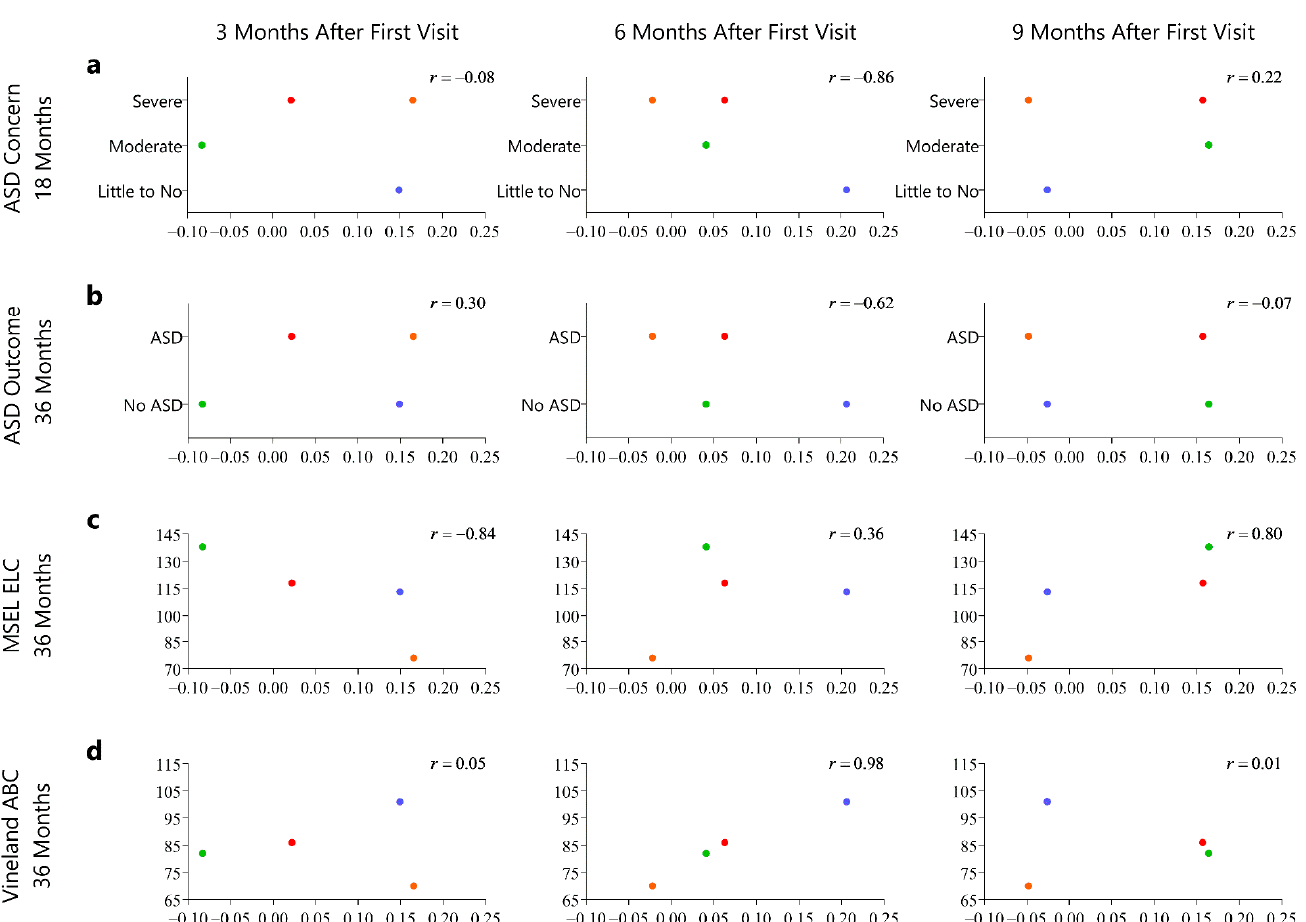
Figure 4. The following series of graphs represents developmental outcomes on the y -axis change in motion complexity score from 3–6, 3–9, and 3–12 months of age. ( a ) The y -axis represents Autism Spectrum Disorder (ASD) concern at 18 months of age indicated by severe concern, moderate concern, and little to no concern. ( b ) The y -axis represents Autism Spectrum Diagnosis at 36 months of age (diagnostic outcome assessment) as indicated by diagnosis of ASD and No ASD. ( c ) The y -axis represents the cognitive ability as measured by the Mullen Scales of Early Learning (MSEL), Early Learning Composite. ( d ) The y -axis represents adaptive skills as measures by the Vineland Adaptive Behavioral Scale-II, Adaptive Behavior Composite.